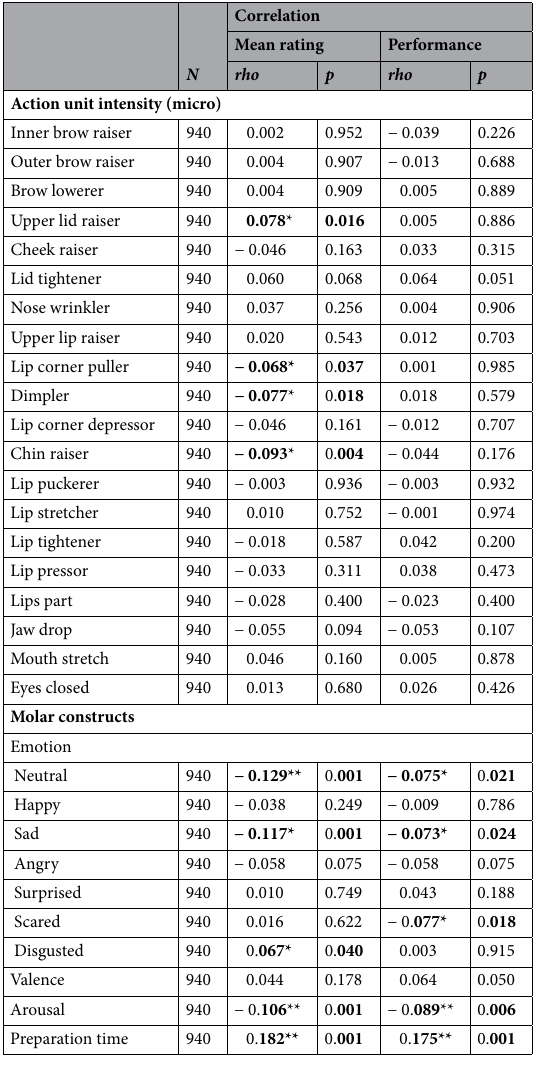
Table 2. Statistics (Spearman correlations) were calculated on the values of the mean rating and the points scored as performance measure of all Videos. Significant correlations are printed in bold and marked with * for p < .05 and ** for p <